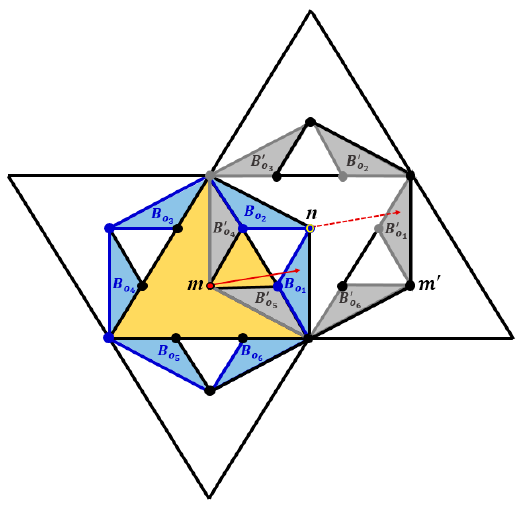
Figure 9. Translations with fractional vectors that start at the even midpoint ( m ) and end at regions B o (where i = 1 ... 6, the blue colored regions with their dark blue colored borders) will produce i semi-bijective translations.